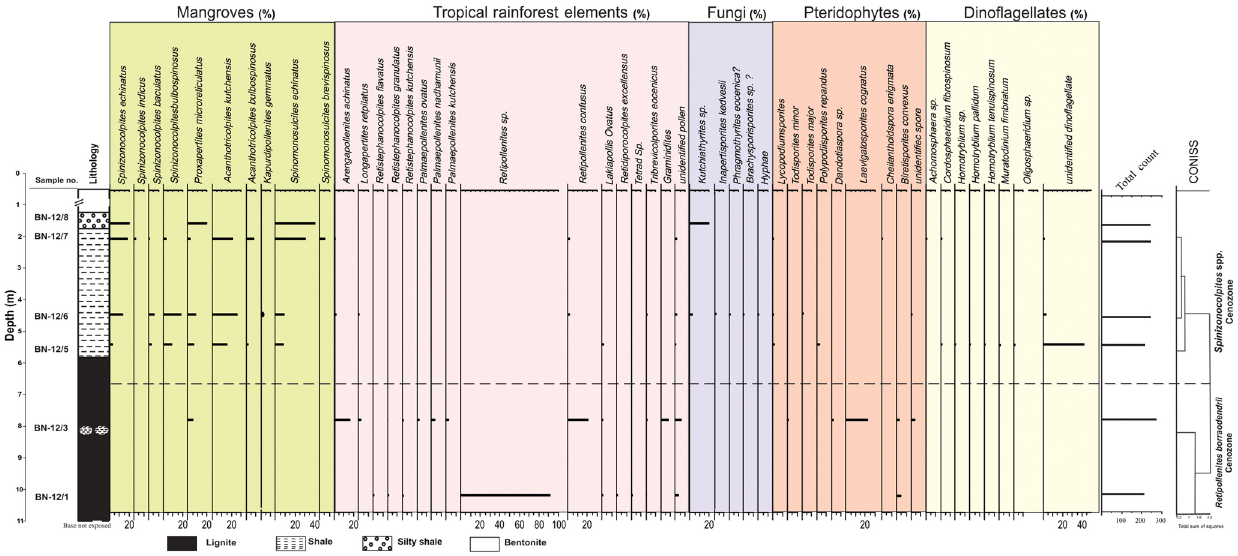
Figure 4. Percentage distribution of palynomorphs in the Surkha lignite mine section, Cambay